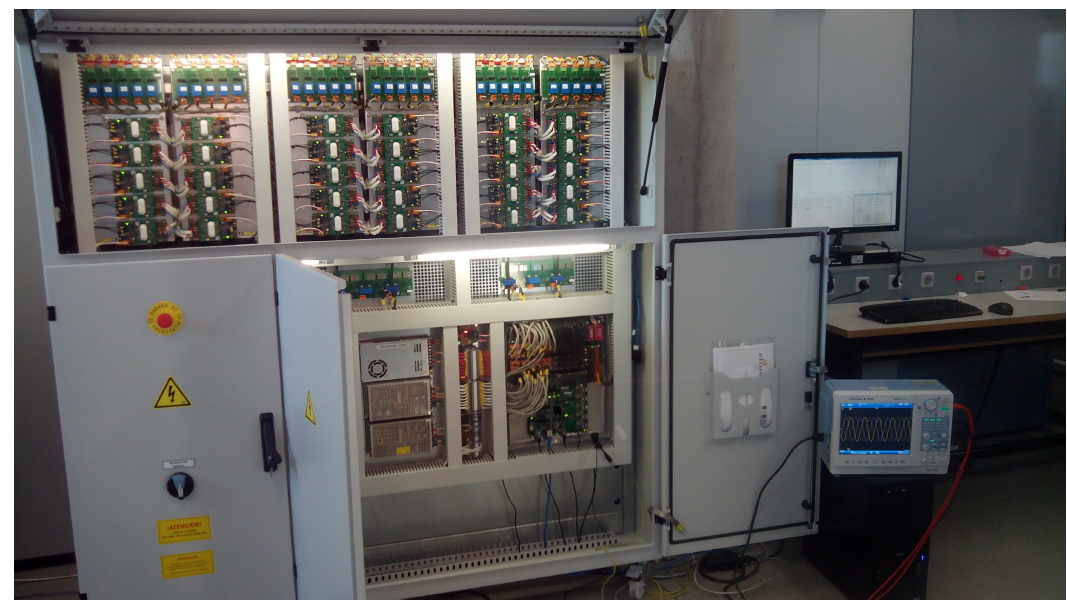
Figure 12. Modular Multilevel Converter prototype with five